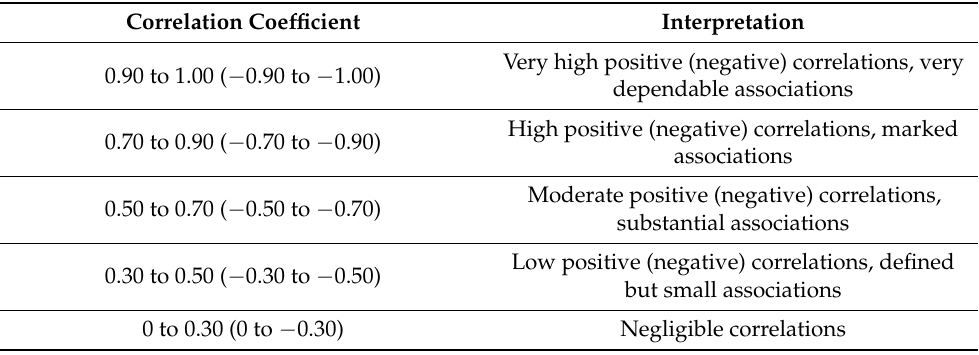
Table 2. Criteria for interpreting the strength of the relationship between two